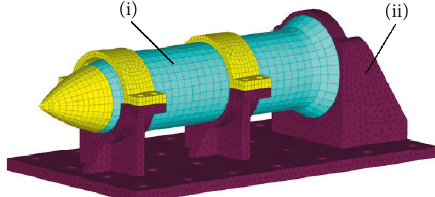
Figure 13: Finite element model. (i) Penetrator. (ii)